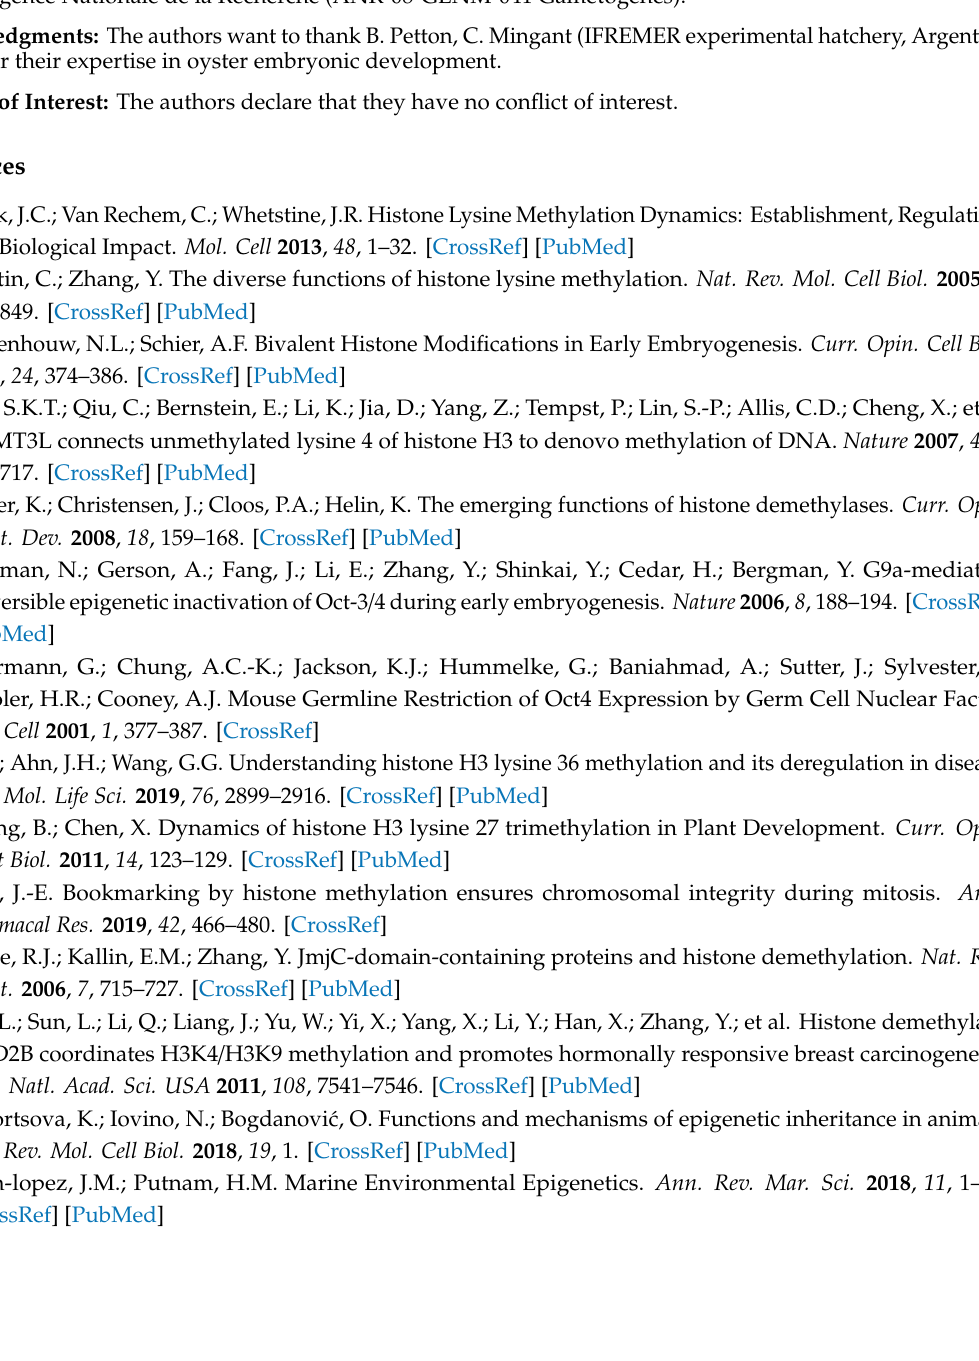
Table S1: qPCR Primers, Table S2: Cluster 1_147 genes, Table S3: Cluster 2_90 genes, Table S4: Cluster 1_139 genes, Table S5 Go term